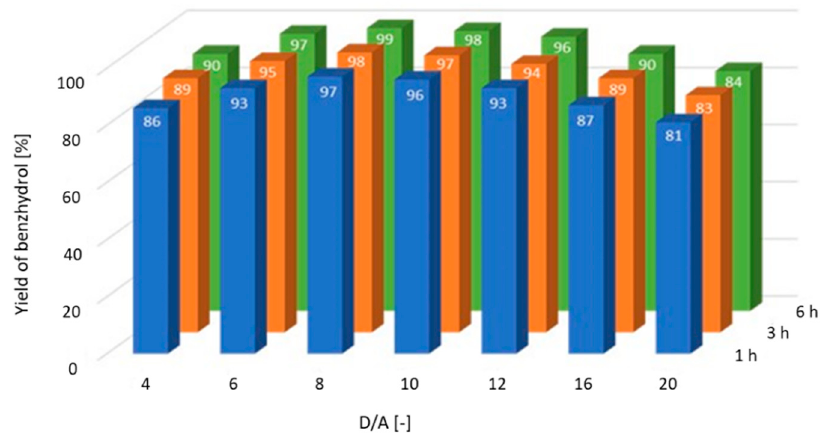
Figure 3. Influence of the donor-acceptor molar ratio on the reaction yield in liquid phase transfer hydrogenation of benzophenone with 2-octanol in the presence of MgO. Reaction conditions: W MgO = 250 ± 5 mg, 3.125 mmol of ketone, selectivity >98%.